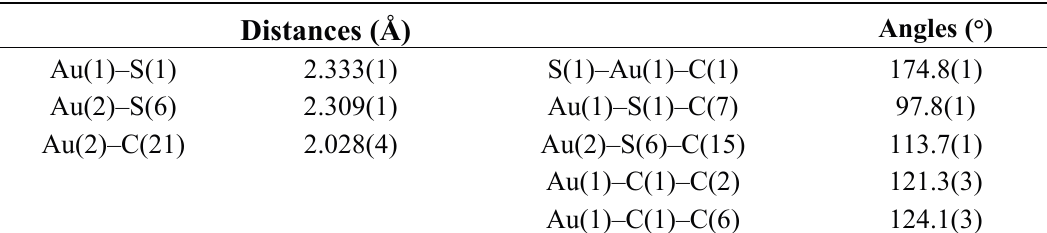
Table 1. Selected bond lengths (Å) and angles (°) for 1